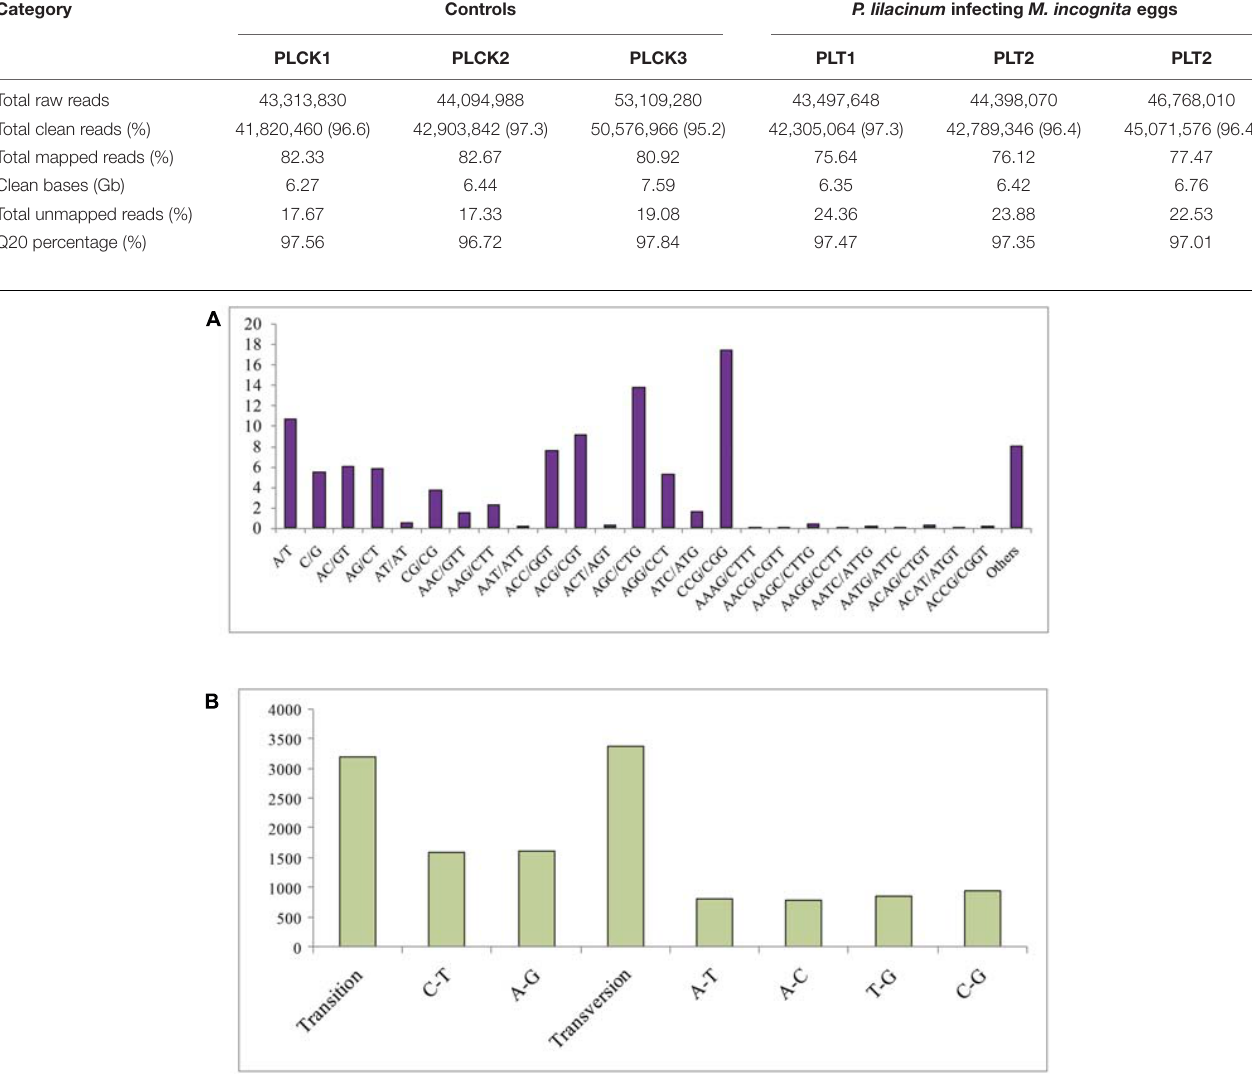
TABLE 2 | Summary of RNA-seq information for each sample from the control and treatment groups. P. lilacinum infecting M. incognita eggs in three biological replicates (PLT1–3); P. lilacinum (controls) in three biological replicates (PLCK1–3). Category